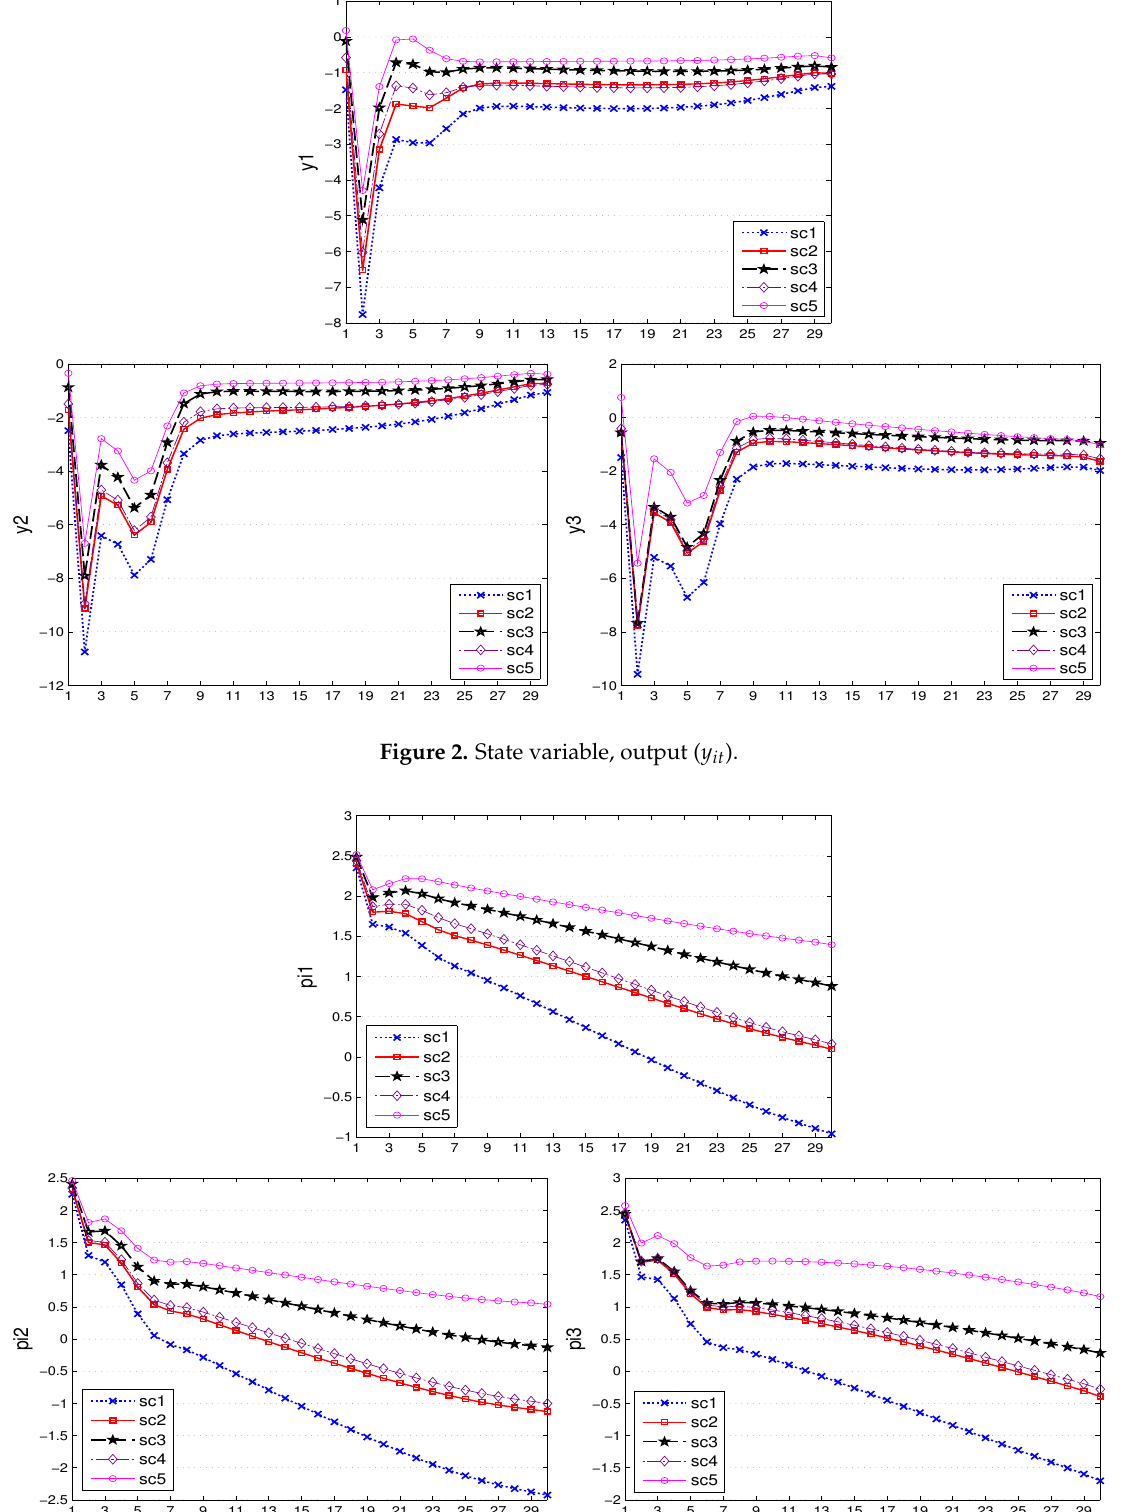
Figure 3. State variable, inflation ( π it